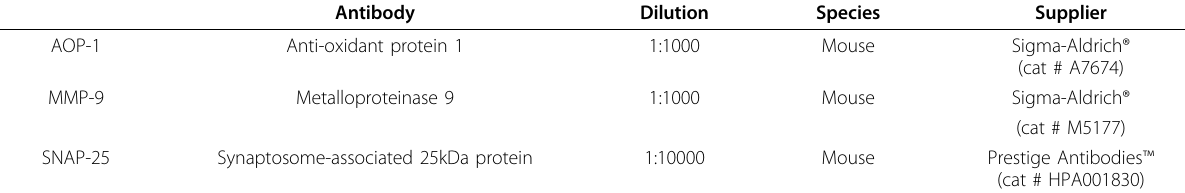
Table 1 Details of the primary antibodies used Antibody Dilution